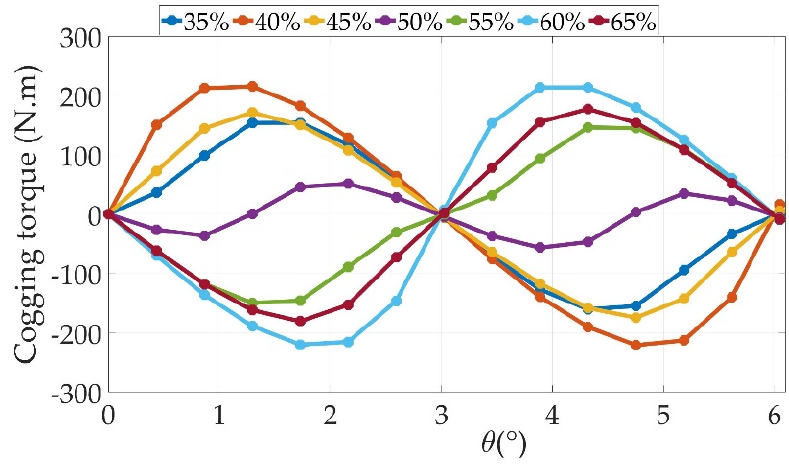
Figure 10. Cogging torque vs. rotor position for different ratios β ( α = 0%). Unlike the case of the back-EMF, Figures 10 and 11 show that the ratio of the stator slot opening has a significant effect on the cogging torque. The latter varies from 107 Nm for β around 50% to 435 Nm for β between 40% and 45%.